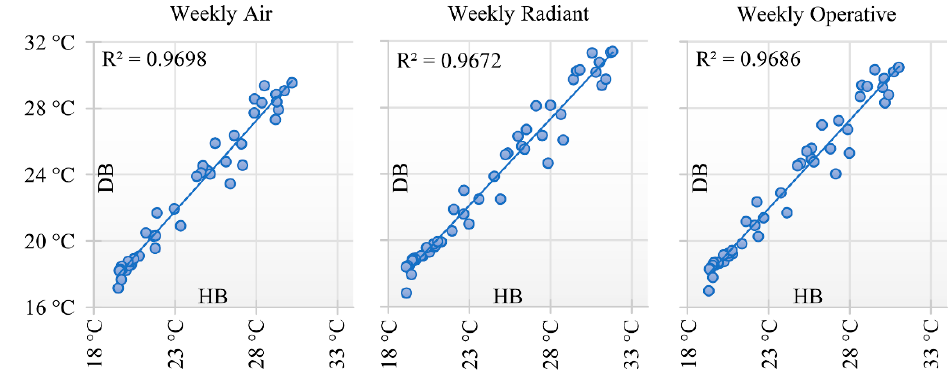
Figure 10. Weekly temperature comparisons between DB and HB.